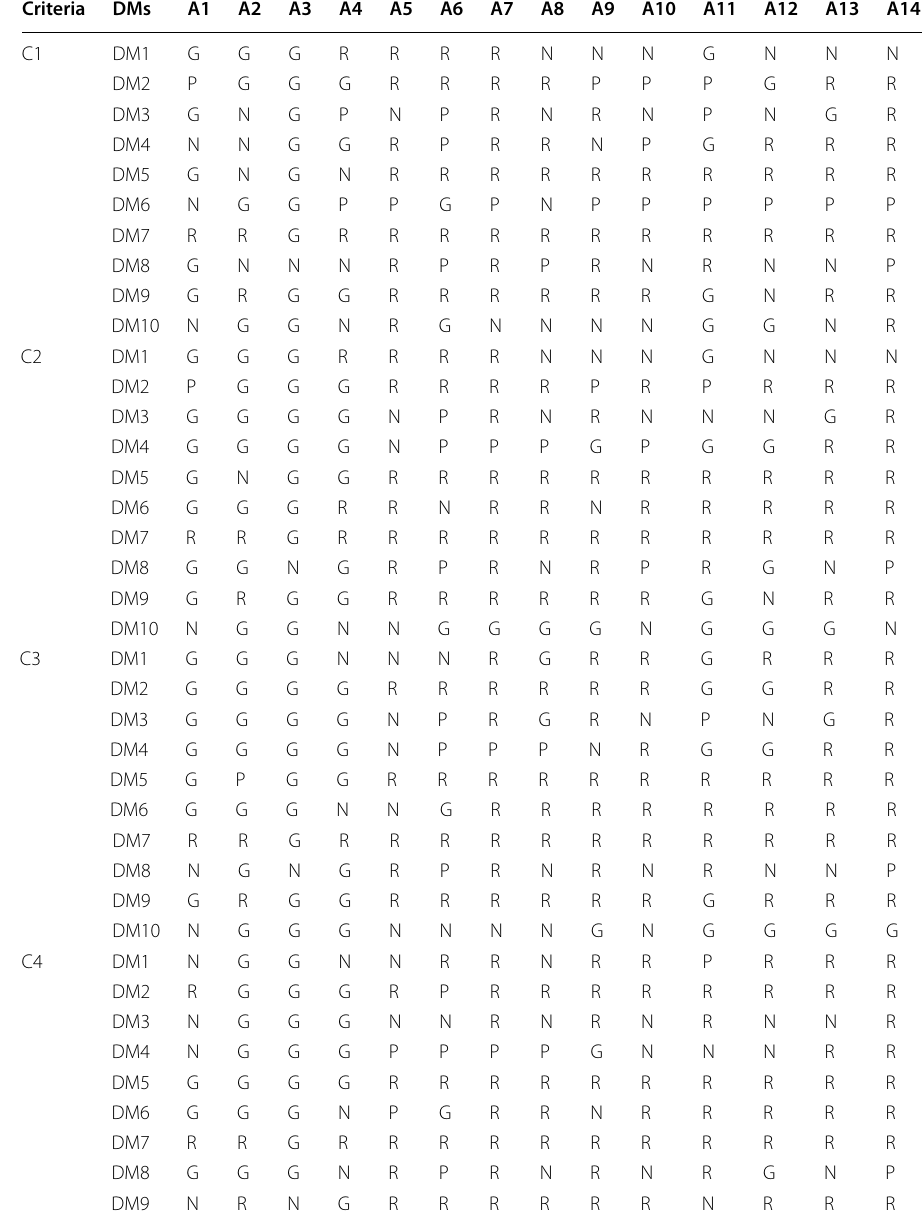
Table 8 Linguistic evaluation of the alternatives